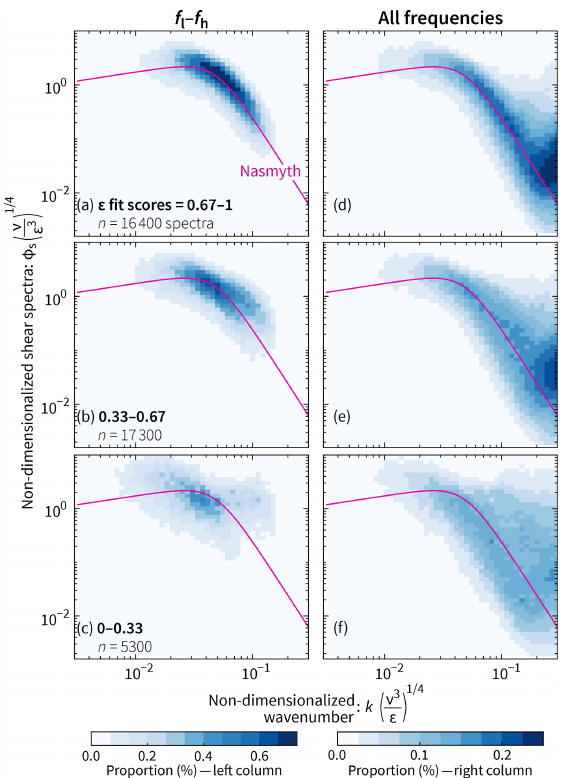
Figure 7. As the (cid:15) fit score decreases from top to bottom, there is a corresponding decrease in the level of agreement and tightness of spread between (i) non-dimensionalized, measured shear spectra and (ii) the Nasmyth spectrum. The two-dimensional histograms in the left column include only spectral coefficients with frequencies between f l and f h ; those in the right column include all frequencies. The total number of spectra in this figure is lower than in Fig. 10 because some low- (cid:15) spectra do not have scores (Eq. 27) and because one of the shear probes failed (Sect.